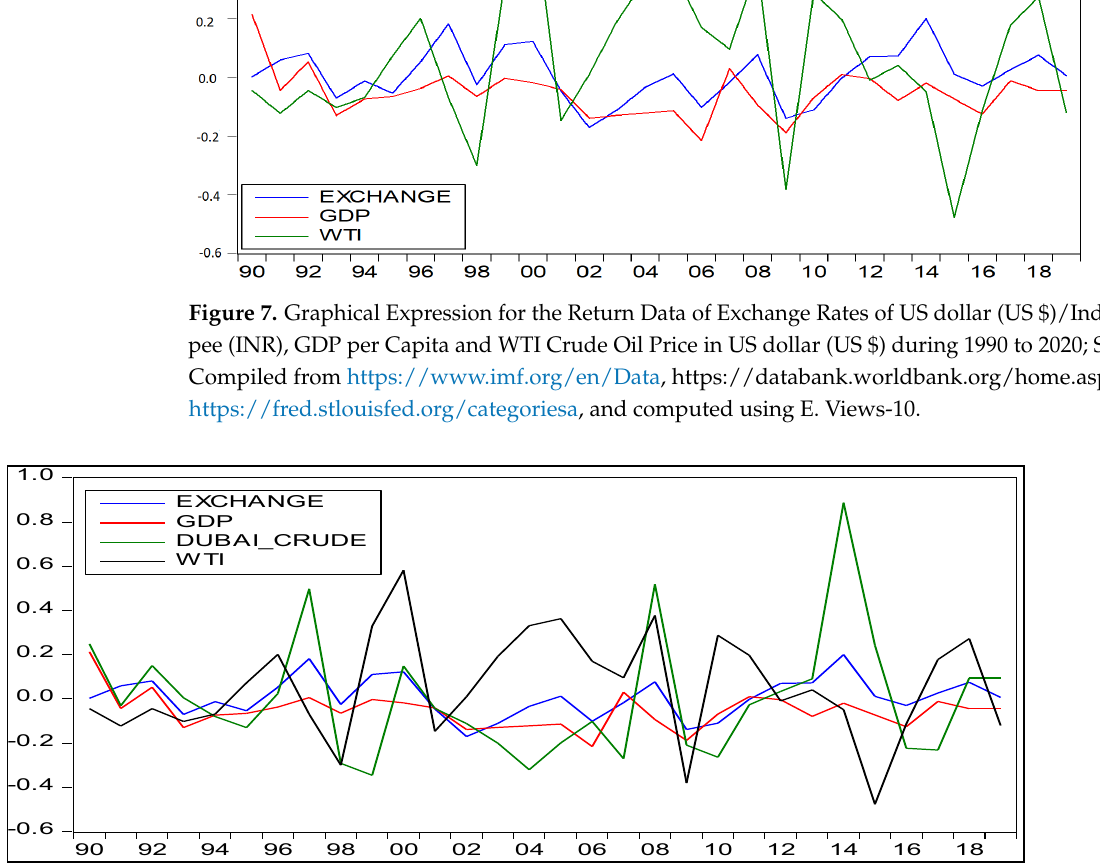
Figure 8. Graphical Expression for the Return Data of Exchange Rates of US dollar (US $)/Indian Rupee (INR), GDP per Capita, WTI Crude Oil Price in US dollar (US $), and during 1990 to 2020; Sources: Compiled from https://www.imf.org/en/Data, https://databank.worldbank.org/home.aspx, and https://fred.stlouisfed.org/categoriesa, and computed using E. Views-10.